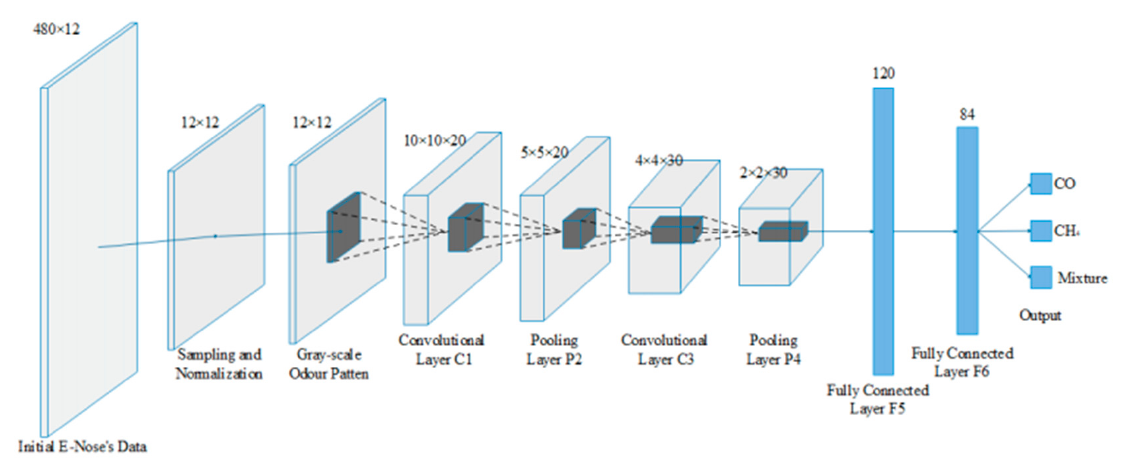
Figure 7. LeNet-5 structure for odor identification [73].